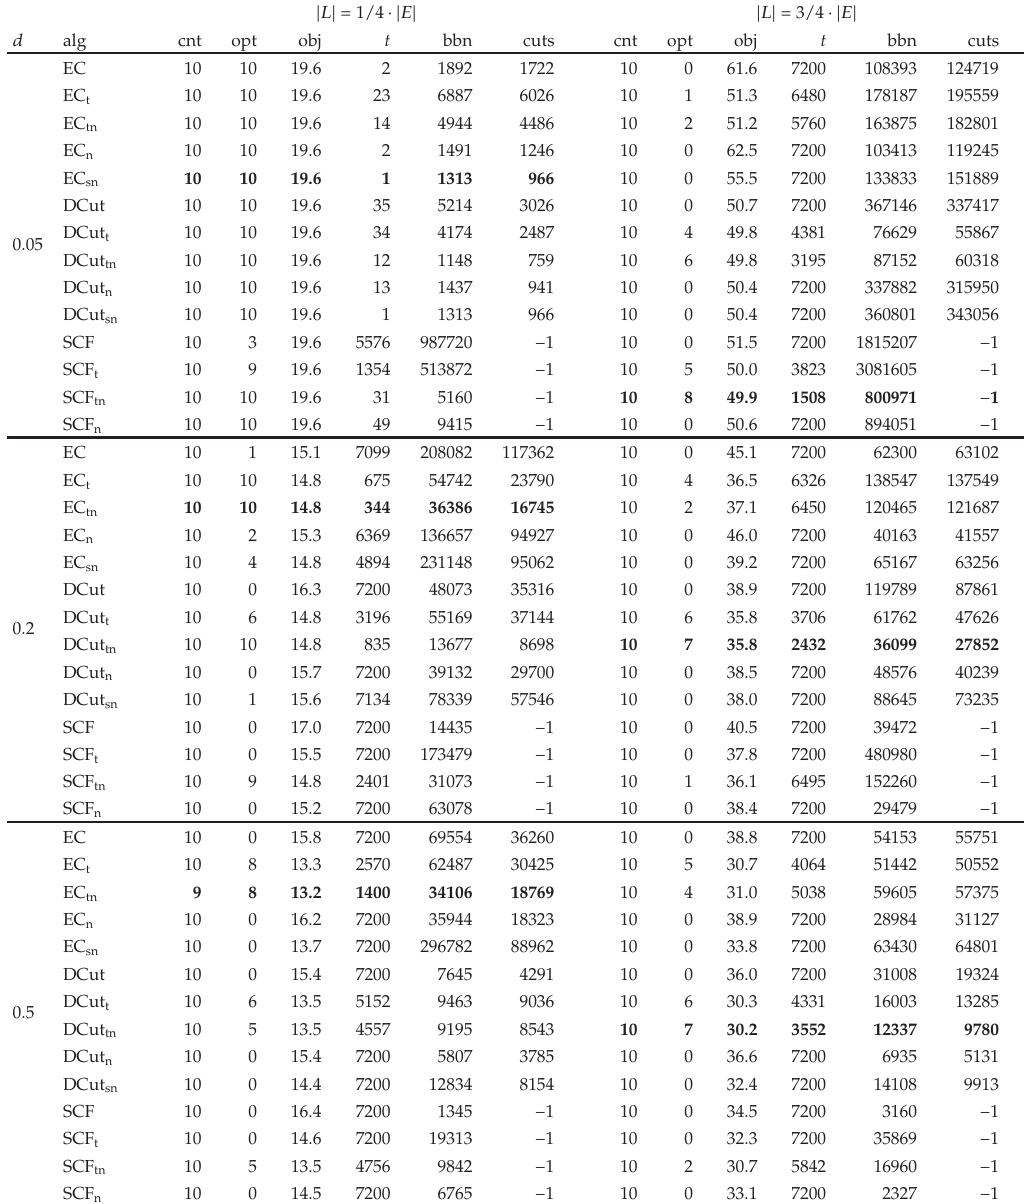
Table 5: Comparison of selected variants of formulations EC, DCut and SCF on the instances from SET-III with | V | (cid:6) 100; α (cid:6)